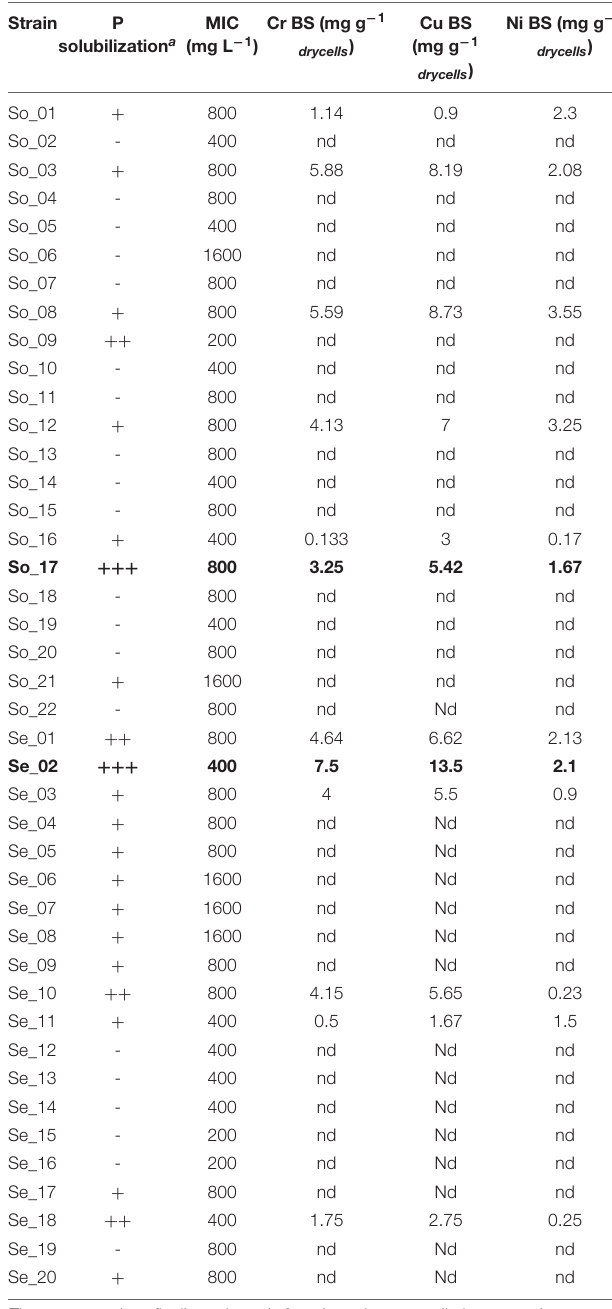
TABLE 2 | Screening of isolated strains for P solubilization ability, minimum inhibitory concentrations (MICs) of Cr, Cu, and Ni and biosorption (BS) toward the three testes